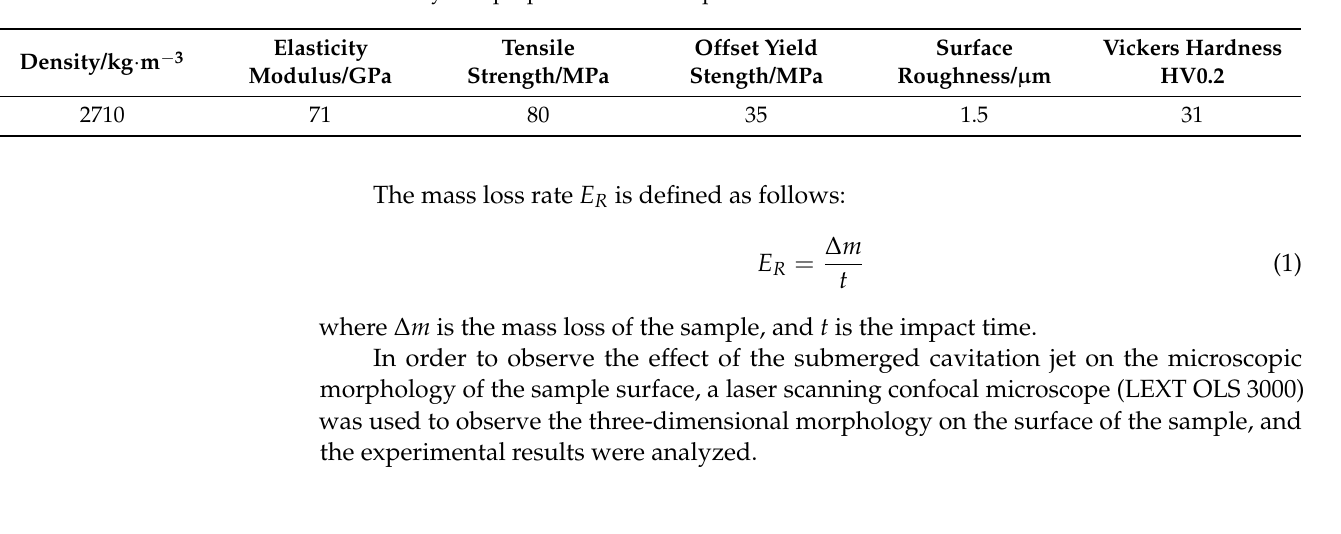
Table 3. Physical properties of the